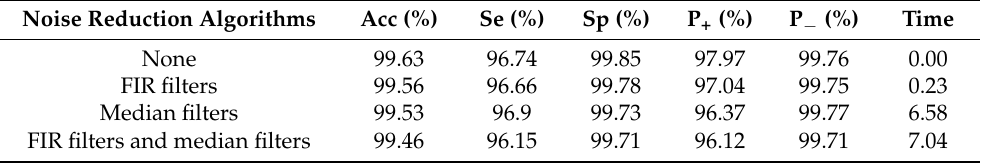
Figure 5. The result of applying different denoising algorithms on the ECG. ( a ) shows a 3-s ECG without denoising; ( b ) and ( c ) illustrate the effect of using finite impulse response (FIR) filters and median filters on the ECG, respectively; ( d ) shows the impact of using FIR filters and median filters on the ECG. Table 8. The performance of applying different noise reduction algorithms on the proposed method.